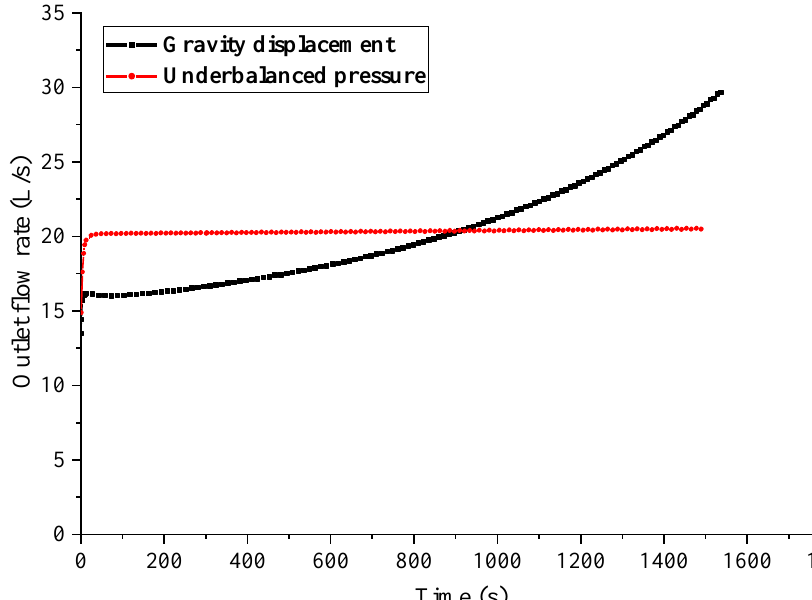
Figure 10. The simulated outlet flow time series for well L.